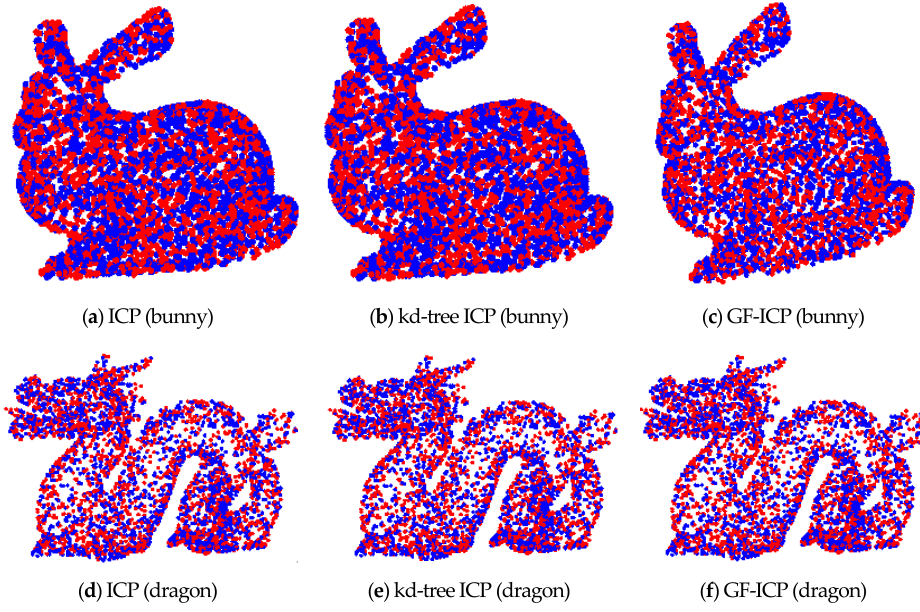
Figure 6. The results of three point cloud matching algorithms.